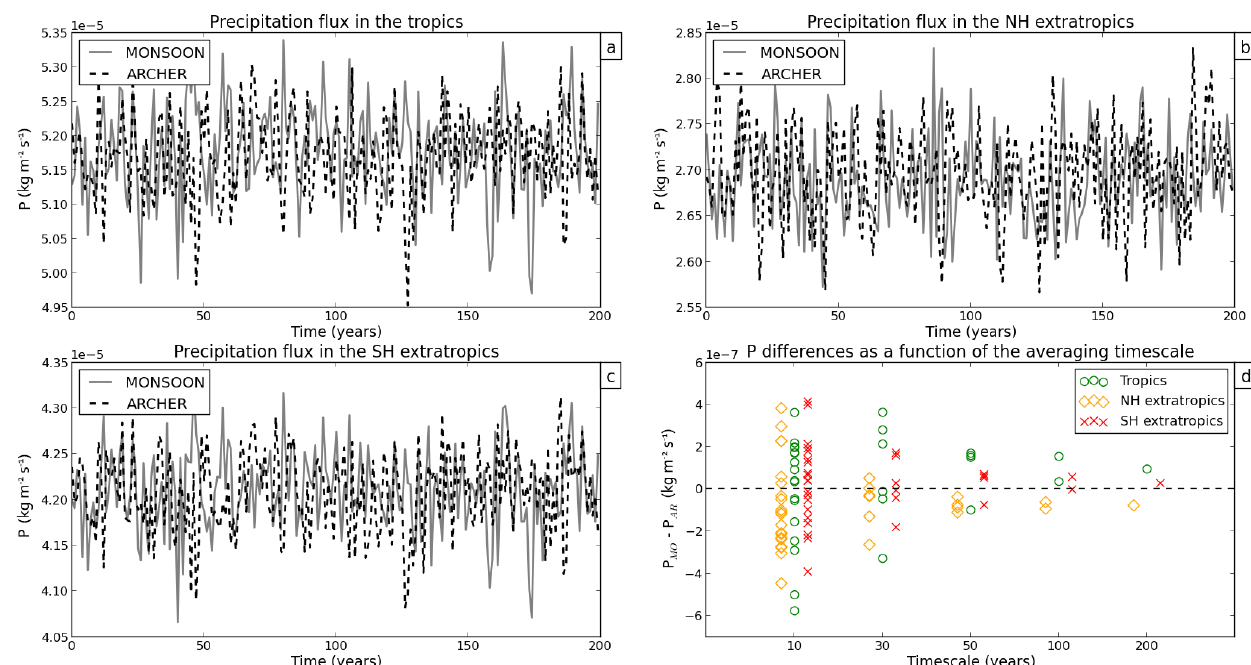
Figure 9. As in Fig. 4 but for P